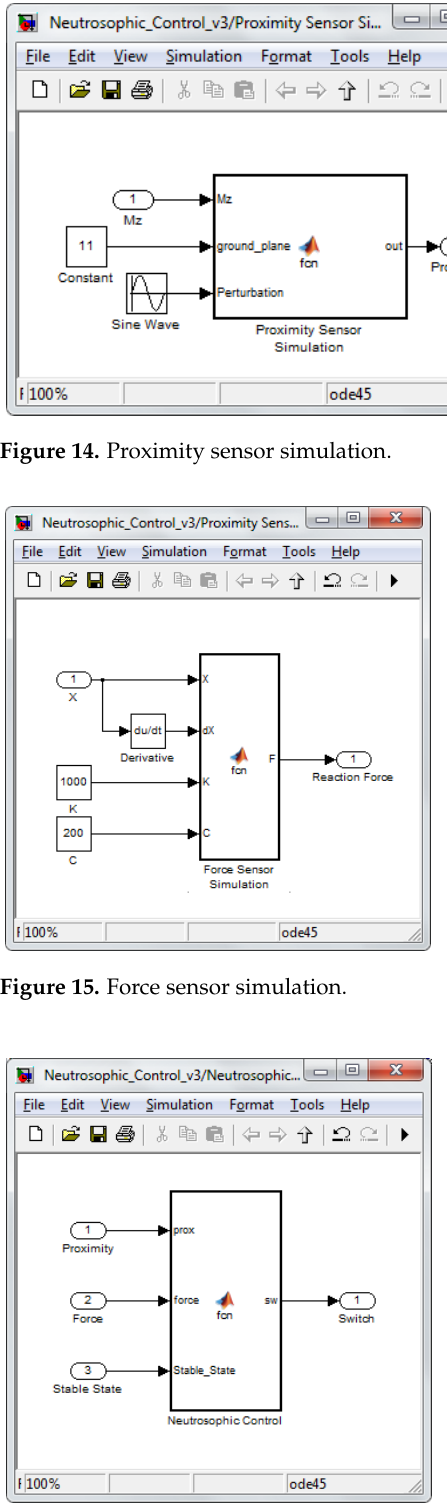
Figure 16. Neutrosophic switching